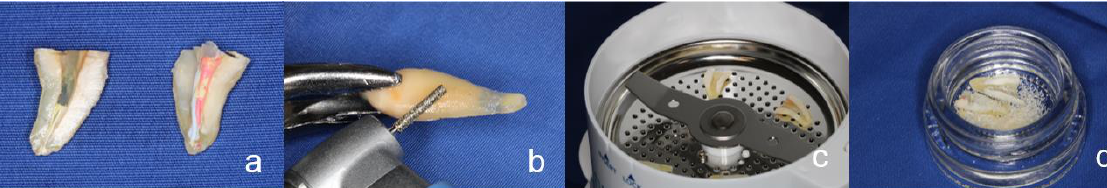
Figure 1. Procedure of the tooth preparation. ( a ) Endodontically treated tooth split in two halves with a rotating diamond disc. ( b ) Removal of debris and foreign material, such as restorations and root filling material, as well as the periodontal ligament, from the root surface with a coarse diamond bur under water cooling. ( c ) Sterile disposable dentin grinder (Smart Dentin Grinder) for particulating the dentin. ( d ) Dentin particulate and dentin shells.